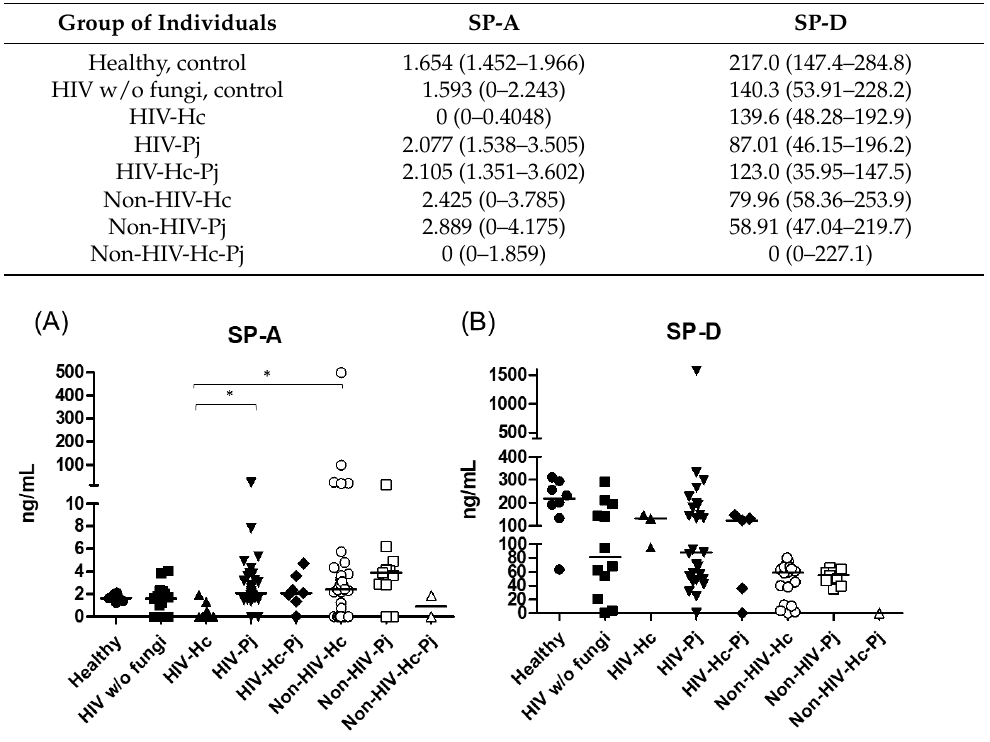
Figure 2. Surfactant proteins determination. Pulmonary SP-A and SP-D were measured in the BAL samples of hospitalized patients, using ELISA; results were obtained in ng/mL. Median values are shown for ( A ) SP-A and ( B ) SP-D. * p < 0.05.